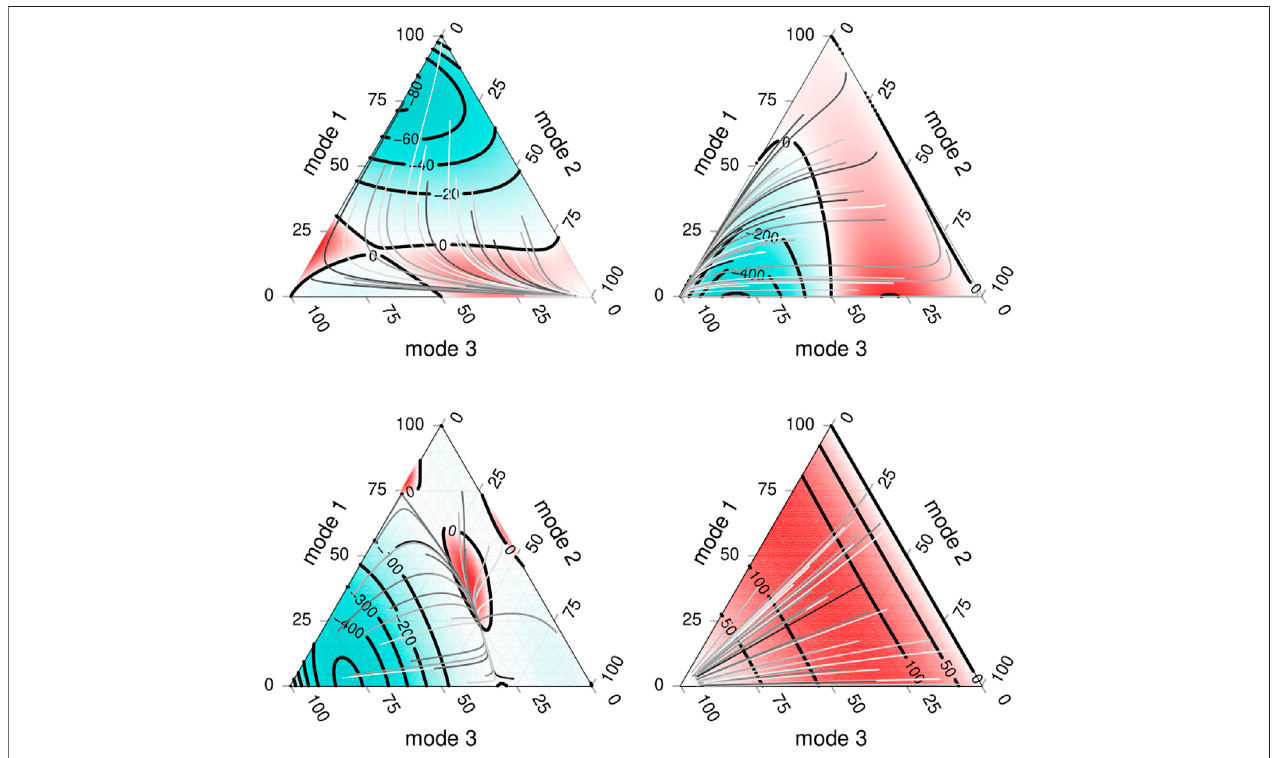
FIGURE6| Visualisationofthedynamicsofthetransportsystem,consideringthreemodesoftransport.Each fi gureshowstheresultconsideringdifferentvaluesof M andof B .Theblueareascorrespondtotrajectoriesthatimprovetheaveragecommutingtimeunderthereplicatordynamics.Theredareascorrespondtotrajectories in the dynamics where individuals change to reduce their commuting time but increase the average commuting time.